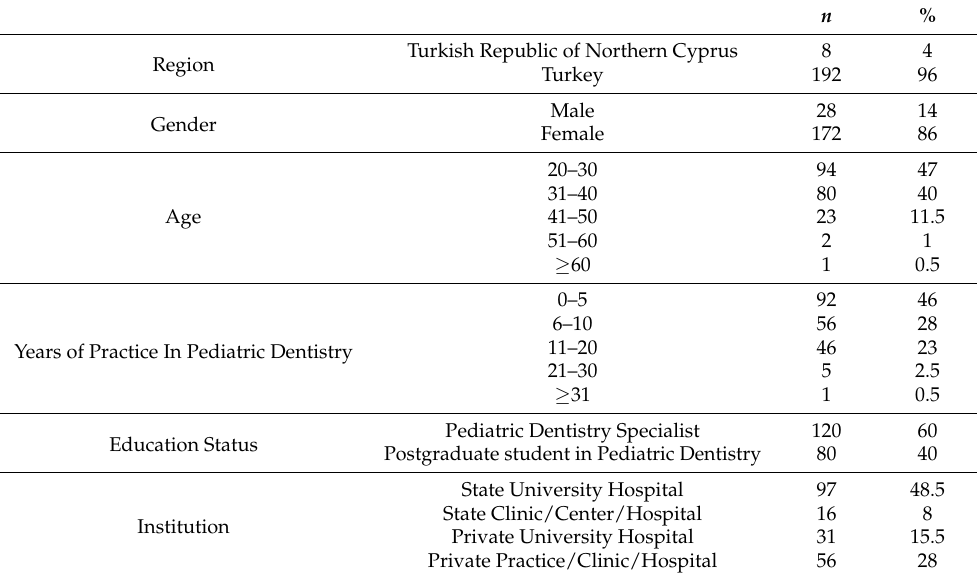
Table 1. Participants’ demographic data.